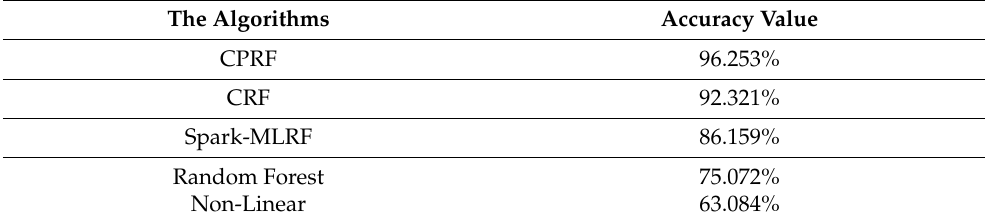
Table 3. Comparison of CPRF with other algorithms.